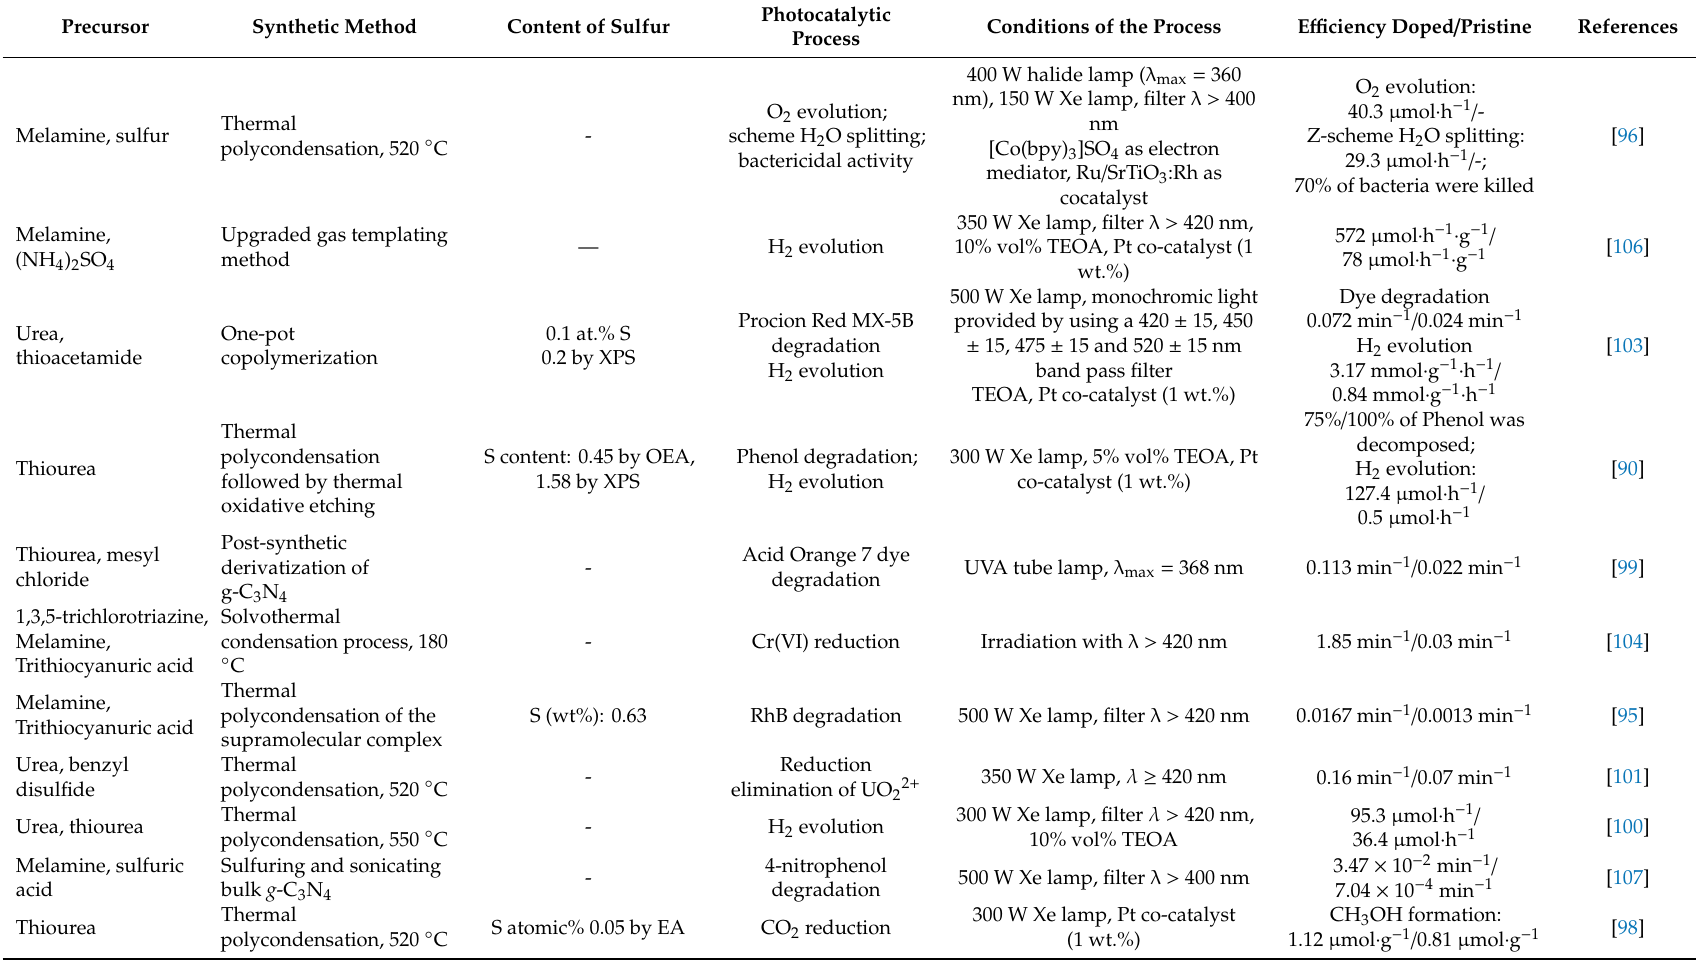
Table 4. Synthetic methods, applications, and photocatalytic e ffi ciency of S-doped g-C 3 N 4